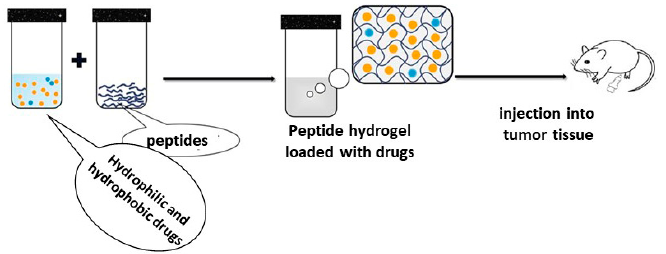
Figure 2. Entrapment of hydrophilic and hydrophobic drugs within peptidic hydrogel for tumor tissue treatments.